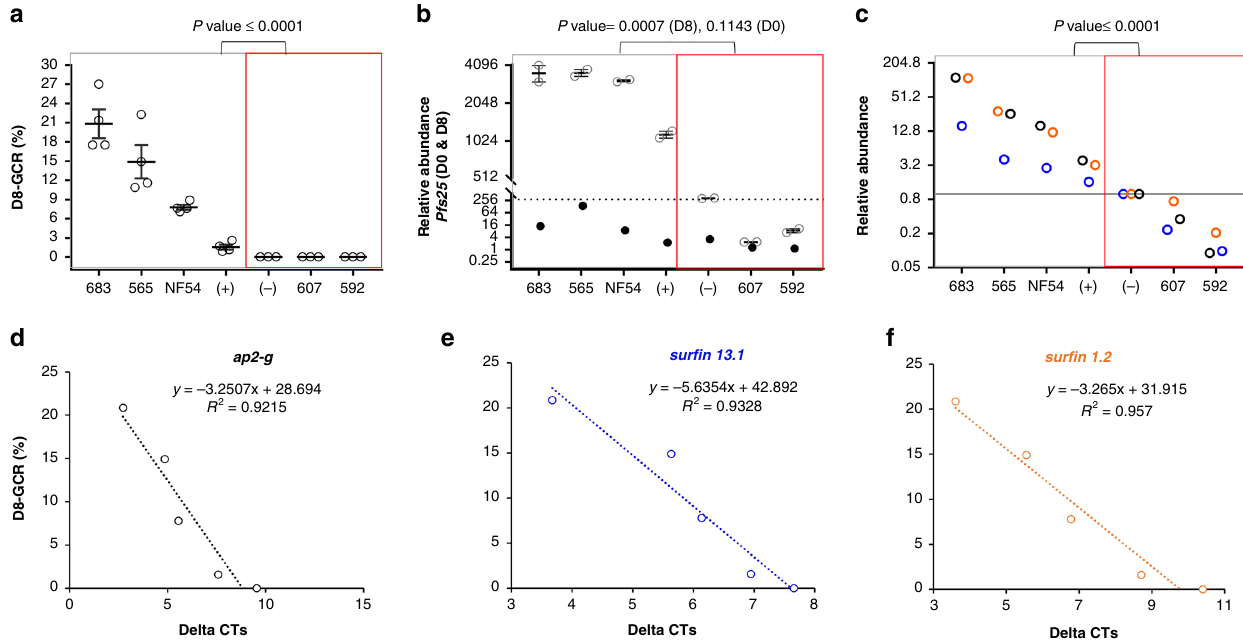
Fig. 4 In vitro validation of the gc-ring biomarkers for gametocyte production. a – c Gametocyte-committed (gc)-ring biomarker expression was evaluated in six P. falciparum lines with a range of day (D)8 gametocyte-conversion rates (GCR). Each biologically independent parasite line (four clonal lines from recent fi eld isolates (683, 565, 607, and 592), NF54, and the Pfgdv1.gfp.dd line cultured in the presence ( + ) and absence ( − ) of Shield 1 (Shld1)) was MACS/sorbitol synchronized. In the next cycle, 70% of the culture was collected for RNA analysis at 10 – 15 h post invasion (hpi) (D0) and N-acetyl glucosamine was added to the remaining culture. Gametocyte conversion was monitored on D8 by microscopy ( a ) and RNA ( b ). a The D8 GCR mean and standard error of the mean (SEM) of n = 4 independent experiments are plotted. b Transcript abundance of gametocyte-speci fi c gene pfs25 in D0 ( fi lled circle) and in D8 (open circle) RNA. The D8 mean and range are indicated for two independent experiments with each independent parasite line, and the dotted line indicates the maximum transcript abundance of pfs25 in the three low (L)-GCR lines. c The relative expression of ap2-g (black), sur fi n 13 . 1 (blue), and sur fi n 1 . 2 (orange) in D0 RNA in n = 7 biologically independent parasite lines. Sbp1 transcript levels were the endogenous control, and RNA levels in Pfgdv1.gfp.dd ( − ) were the reference. Differences between the high (H, n = 4)- and the L-GCR ( n = 3) biologically independent parasite lines were analyzed using a two-sided Mann – Whitney test ( a – c ), and the P values indicated. d – f D8 GCR correlation with the Δ Ct of ap2-g ( d ), sur fi n 13.1 ( e ), and sur fi n 1 . 2 ( f ). Δ Ct was calculated using sbp1 as the control gene. The linear trend line for n = 5 independent parasite lines, all four H-GCR lines (683, 565, NF54, and Pfgdv1.gfp.dd + Shld) and the reference L-GCR line, (Pfgdv1.gfp.dd -Shld1), is indicated with its equation and the R 2 value. Source data are provided as a Source Data fi